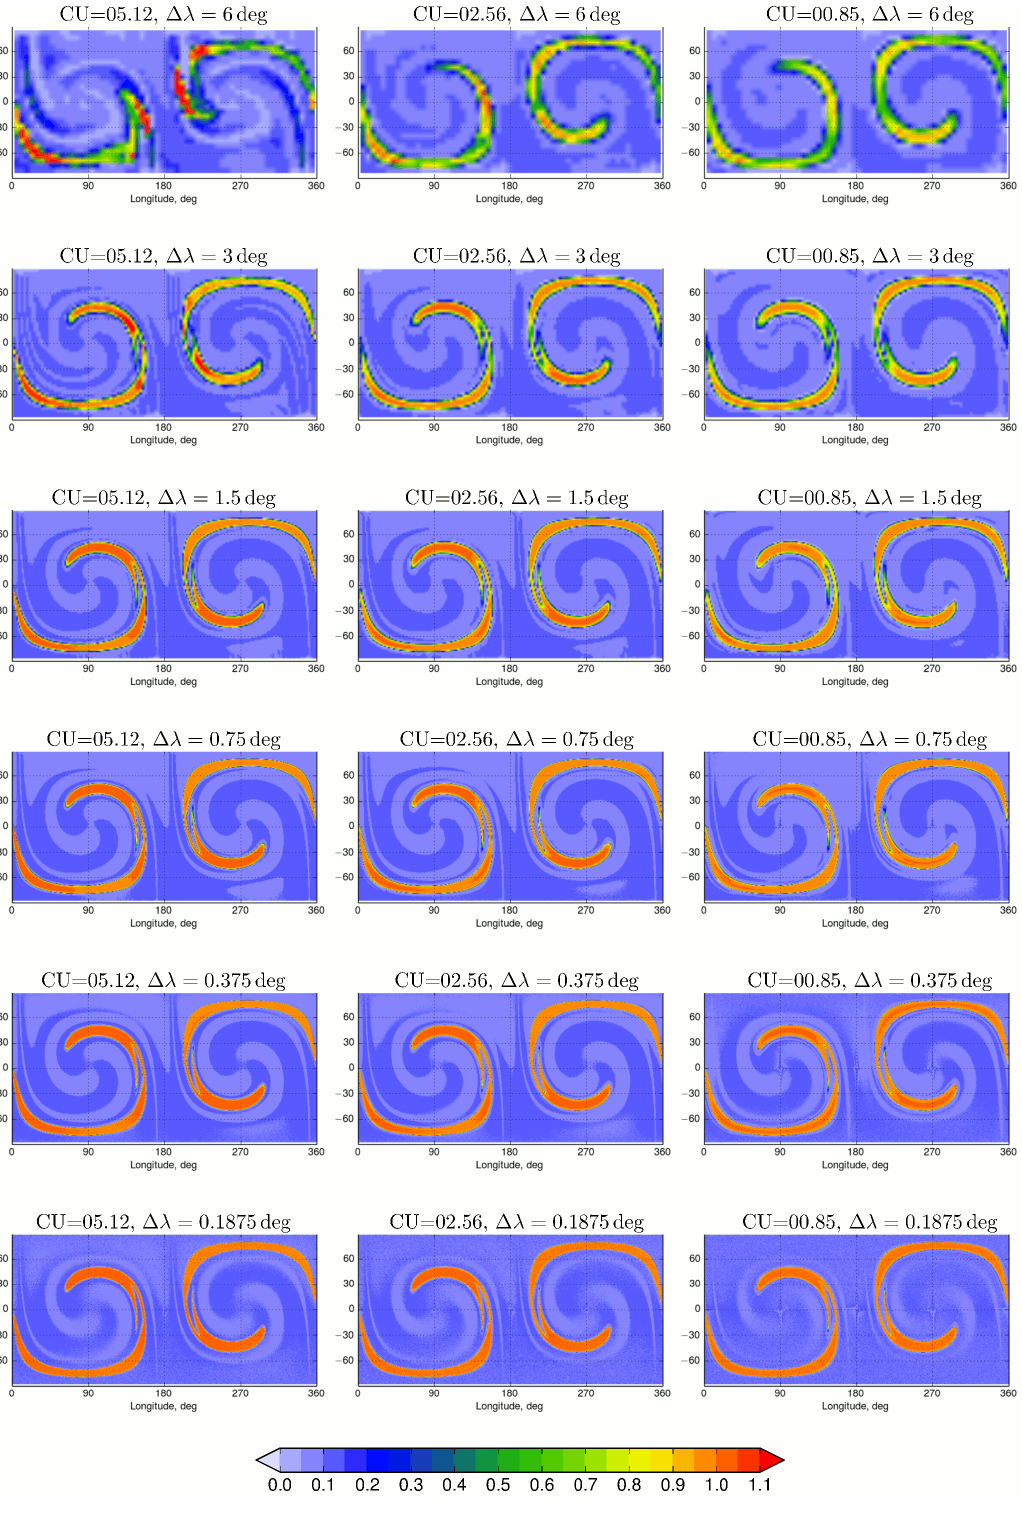
Figure 9. Half-period ( t = T/ 2) shapes for the 2-D global test with slotted cylinders for different spatial and temporal resolutions. Without